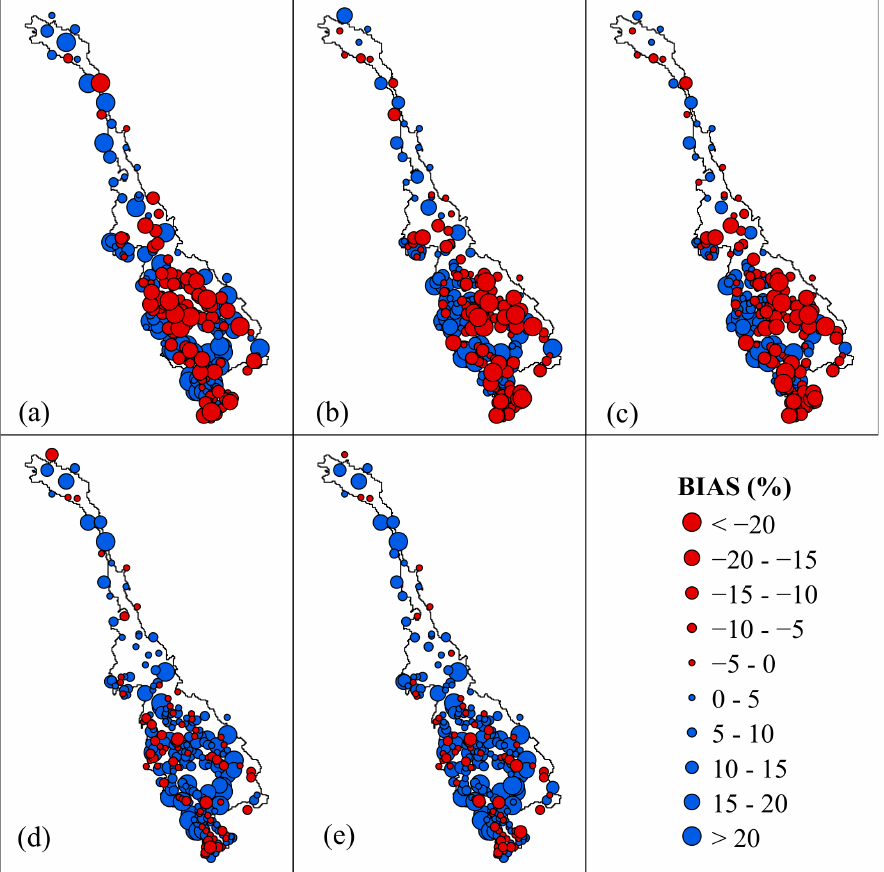
Figure 10. BIAS of MSWEP ( a ), MSWEP-QM ( b ), MSWEP-LS ( c ) compared with gauge observations from 1998 to 2007 at daily scale; the second line shows the change in BIAS between MSWEP-QM ( d ), MSWEP-LS ( e ), and MSWEP, in which blue points mean BIAS decreased, and red means the opposite.